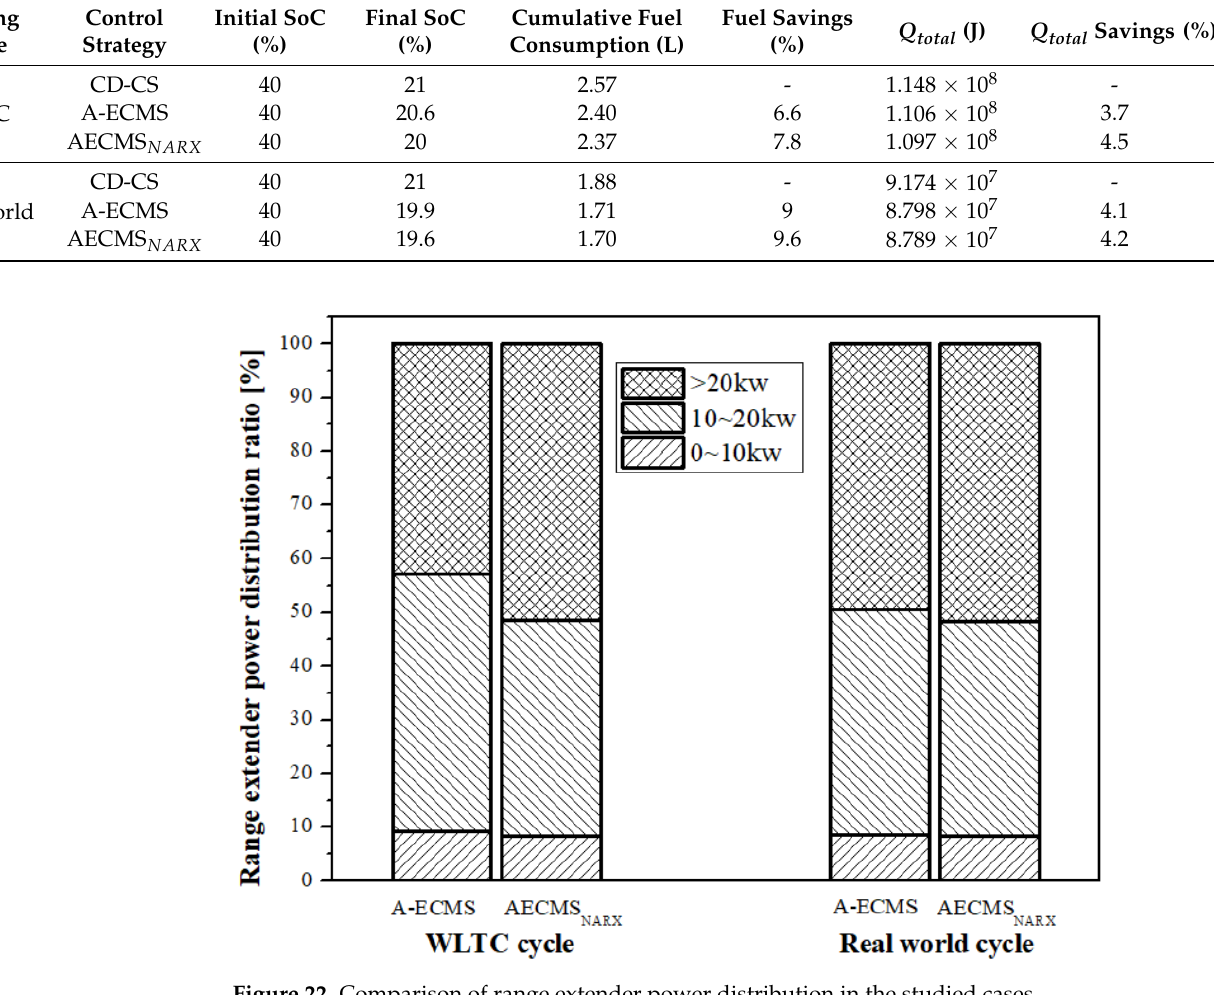
Figure 22. Comparison of range extender power distribution in the studied